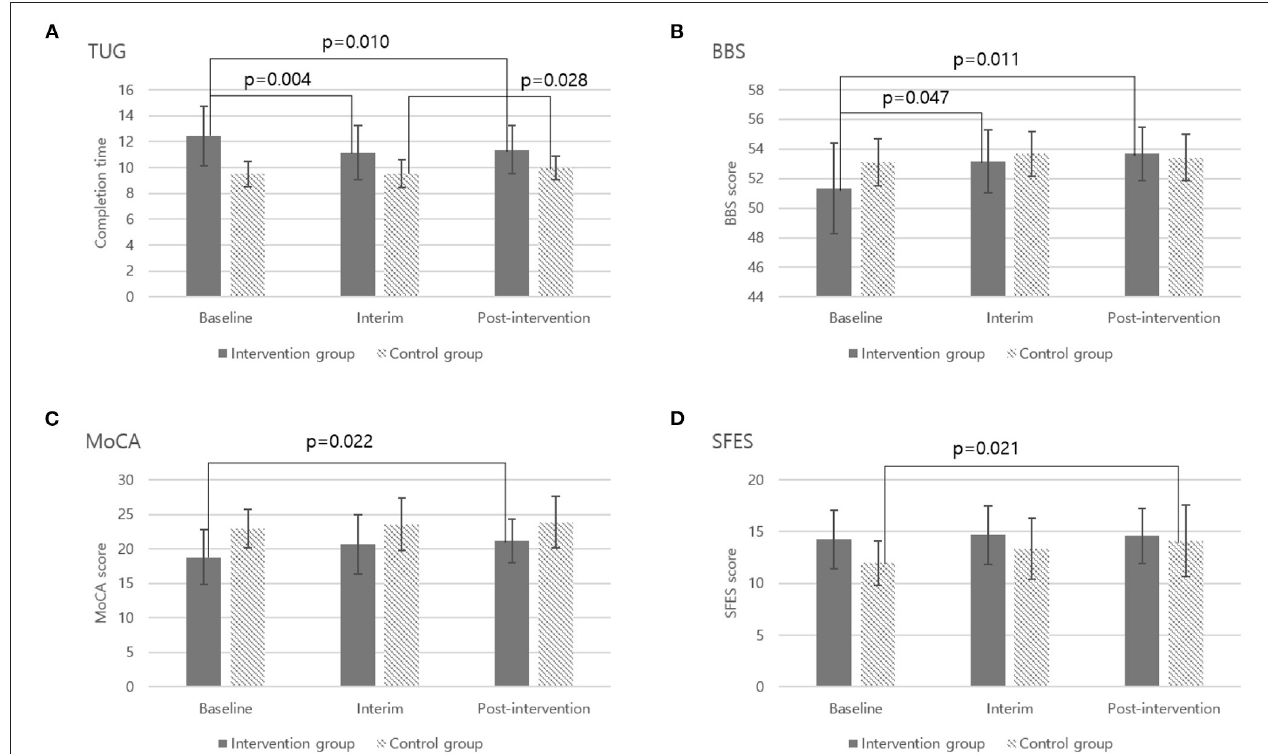
FIGURE 5 | Significant outcome measures from two separate Friedman tests and post-hoc analyses. (A) Timed Up and Go-TUG, (B) Berg Balance Scale-BBS, (C) Montreal Cognitive Assessment-MoCA, (D) Shorten Fall Efficacy Scale-SFES.